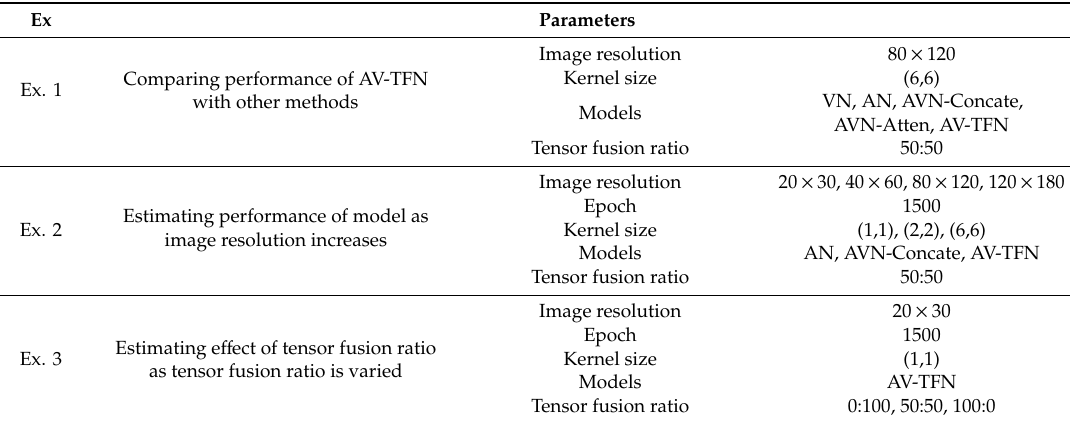
Table 2. Summary of experiments and